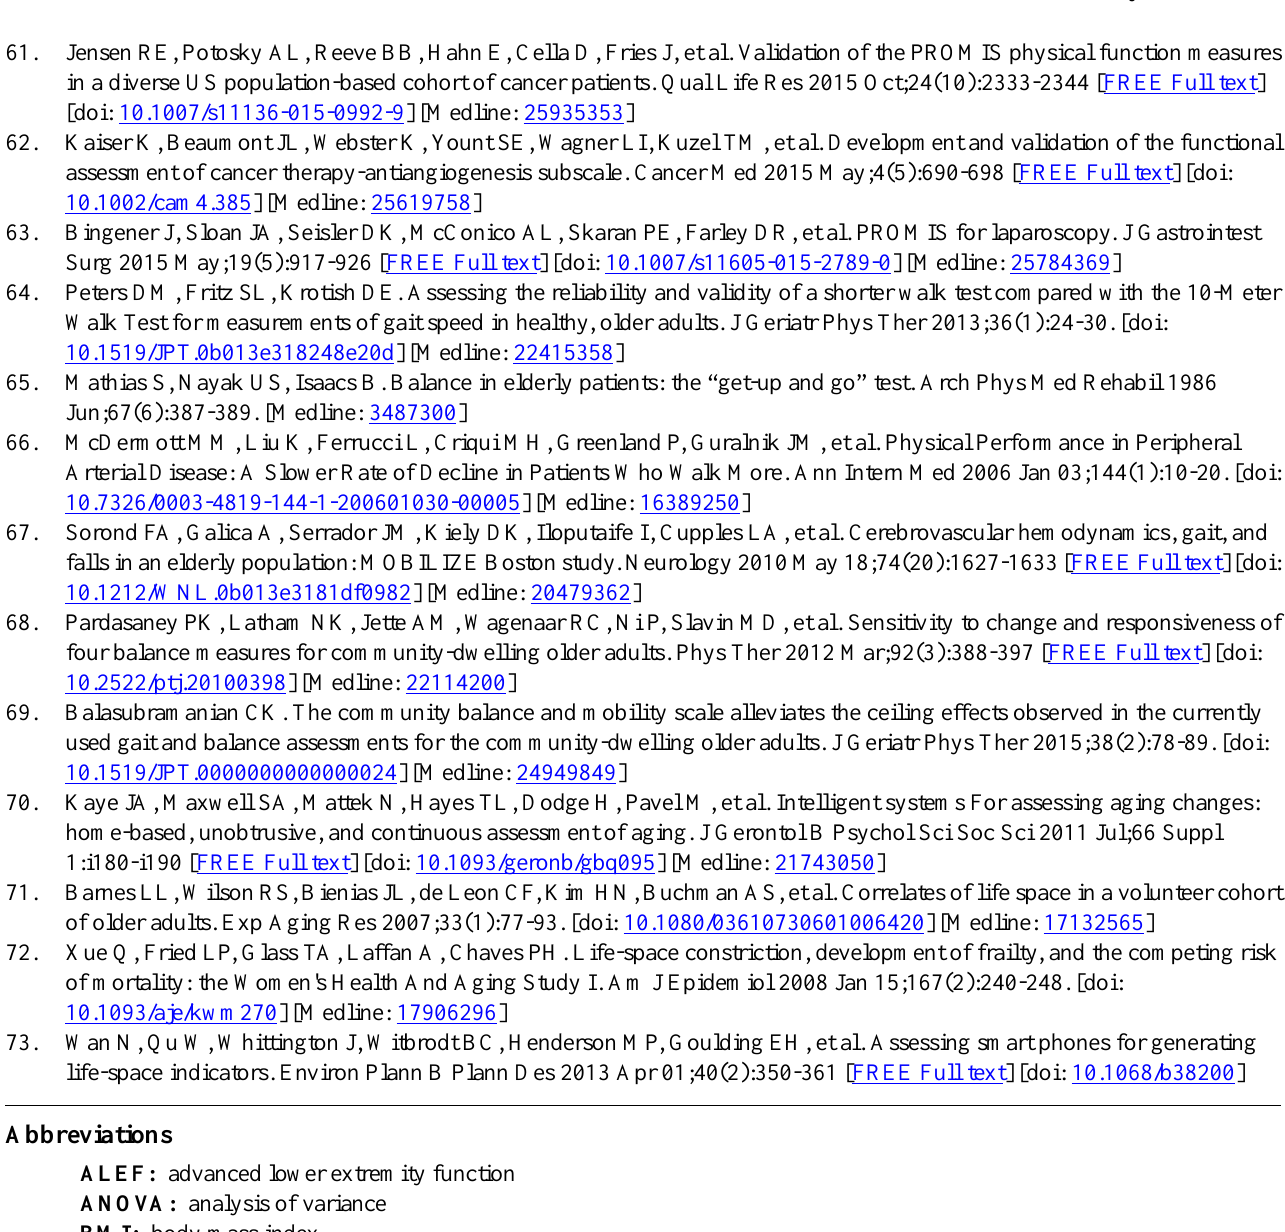
F8W: Figure-of-8 Walk LLFDI: Late Life Function and Disability Instrument PROMIS: Patient Reported Outcomes Measurement Information System, short form version 1.0 PROMIS-GH: Patient Reported Outcomes Measurement Information System Global Health, short form version 1.1 PROMIS-PF: Patient Reported Outcomes Measurement Information System Physical Function PROMIS-PH: Patient Reported Outcomes Measurement Information System Physical Health REDCap: Research Electronic Data